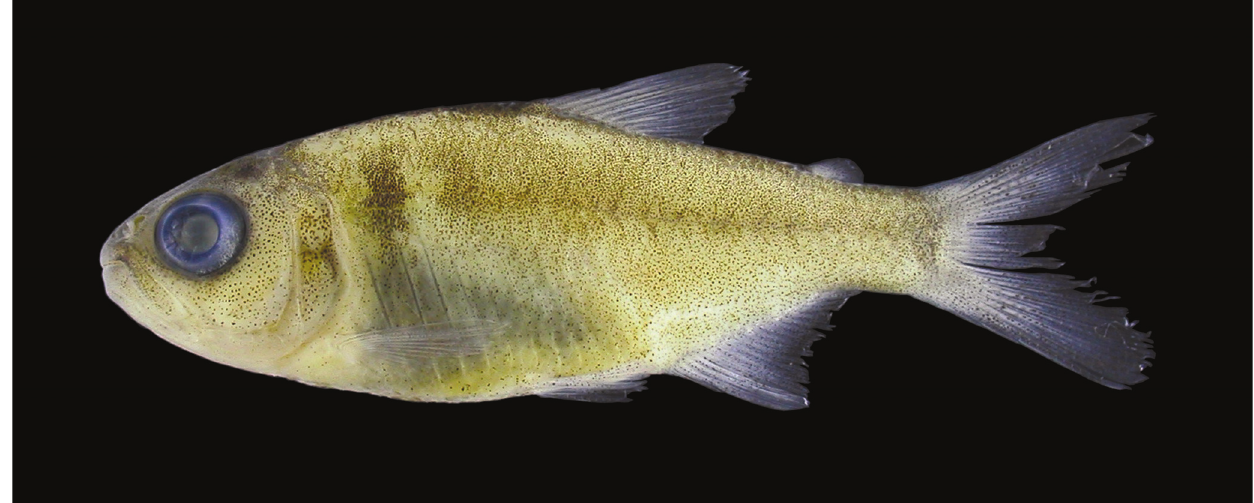
Fig. 5. Moenkhausia dasalmas , paratype, UFRGS 11194, 28.6 mm SL, tributary of rio das Almas, Cavalcante, Goiás, Brazil.